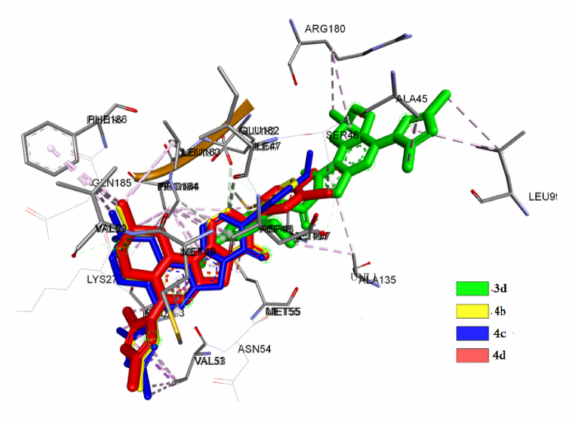
Figure 6. Superposition of 3d, 4b, 4c and 4d in subsite 3 of GABA A